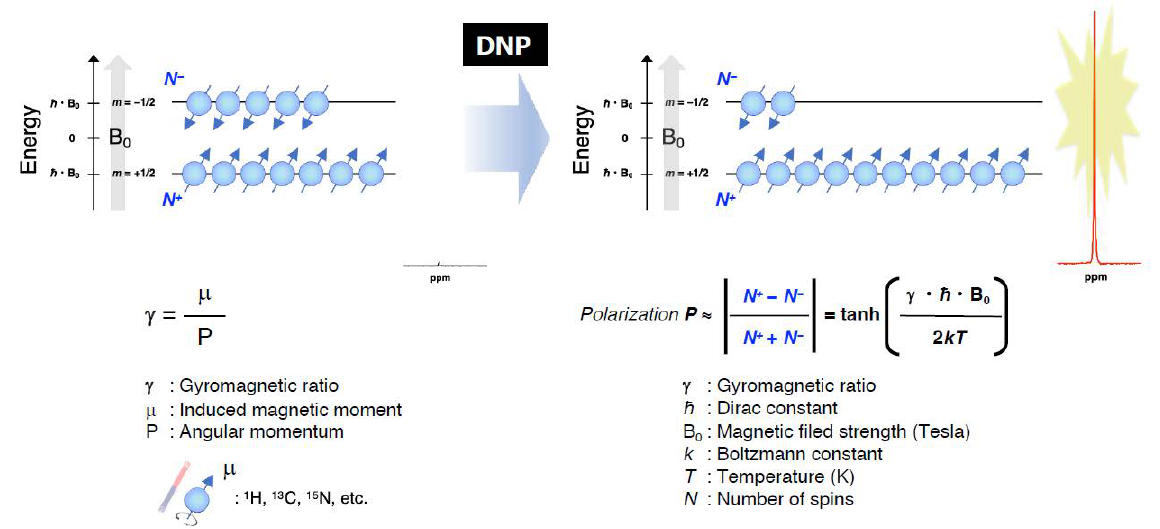
Figure 7. A schematic representation of the Zeeman splitting of nuclear spins (I = 1/2) and the polarization for obtaining the enhanced NMR signals by DNP under the magnetic field.